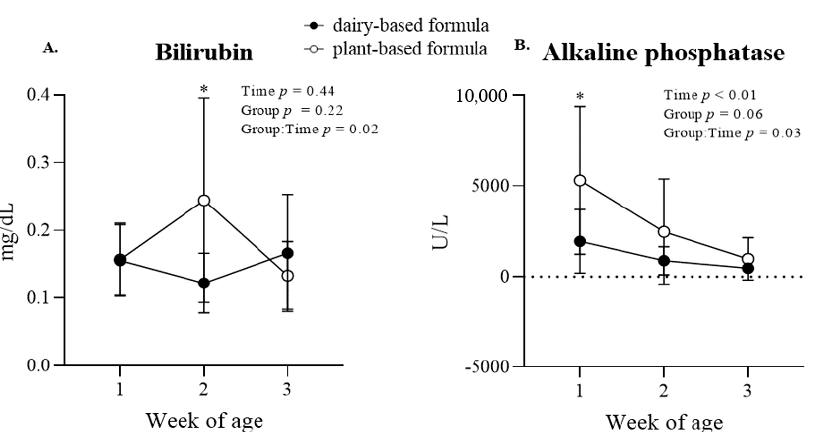
Figure 6. Plasma concentration of bilirubin ( A ) and alkaline phosphatase ( B ) at 1, 2, and 3 weeks of age of piglets fed either a dairy-based (Similac Advance powder) or a plant-based (Else nutrition powder) formula ( n = 9/group) from postnatal day (PND) 2 until PND 21. * Represents the statistical difference between diet groups at the given time point. Table 3. Group average per week of age (w1, w2, w3) of enzymes measured in the plasma of piglets fed either a dairy-based or a plant-based formula ( n = 9/group) from postnatal day (PND) 2 until PND 21.